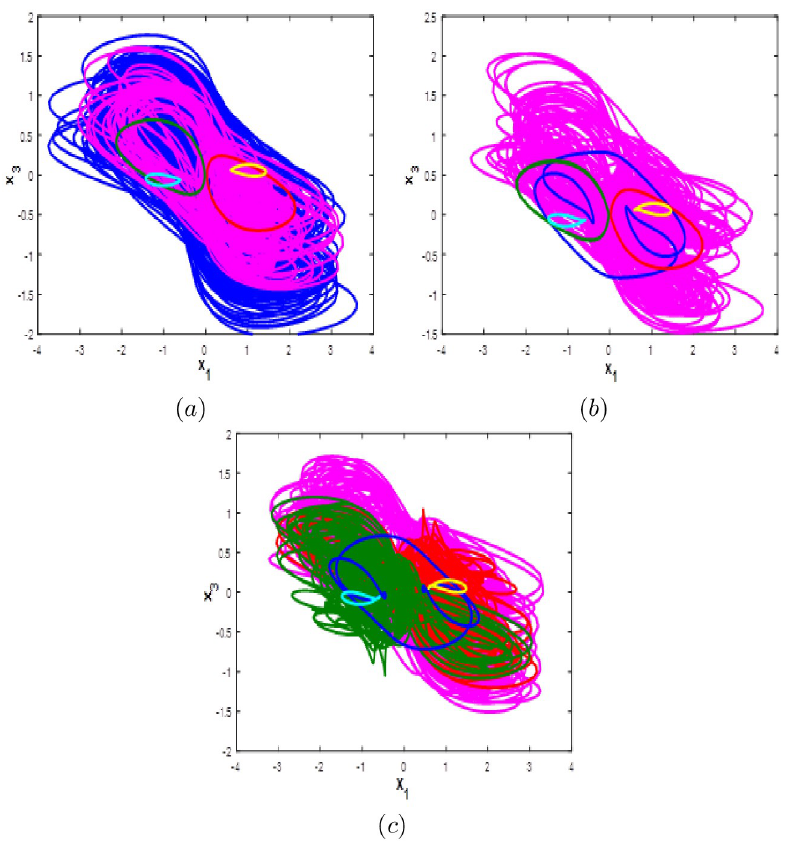
Fig 14. Coexistence of six different attractors projected on the x 1 − x 3 plane. (a) Coexistence of one hyperchaotic attractor (blue), one chaotic attractor (magenta) and four periodic attractors when b = 0.5. (b) Coexistence of one chaotic attractor and five periodic attractors when b = 1.5. (c) Coexistence of three chaotic attractors and three periodic attractors when b = 2.5.